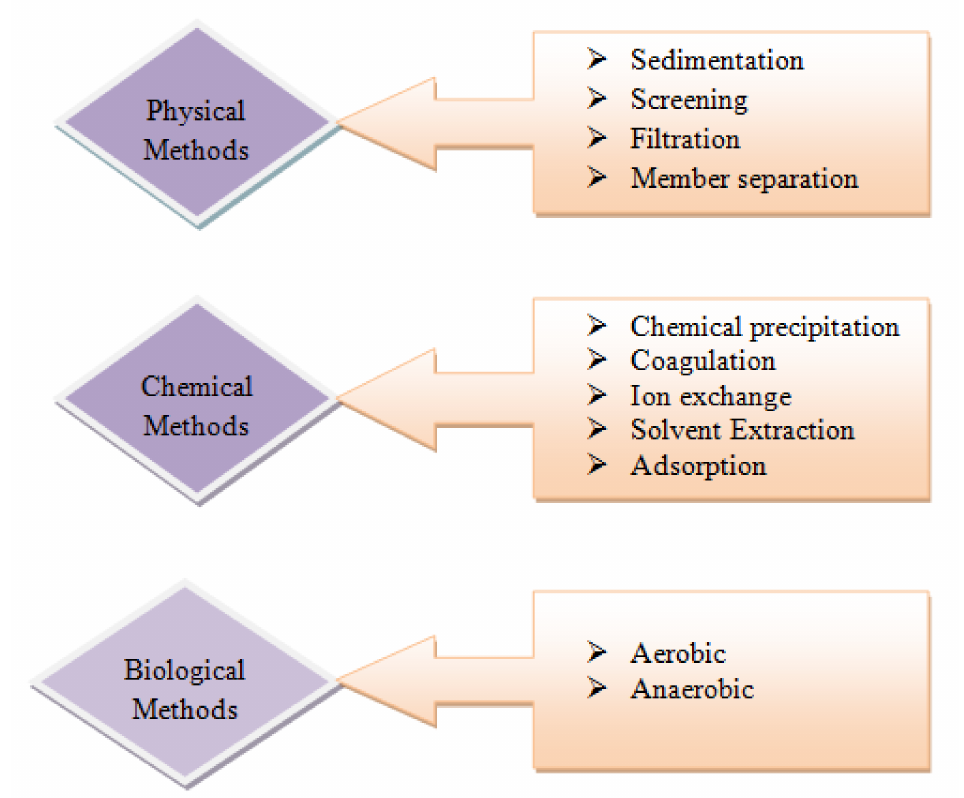
Figure 4. Conventional technologies for heavy metal removal, reprinted with permission from [52].